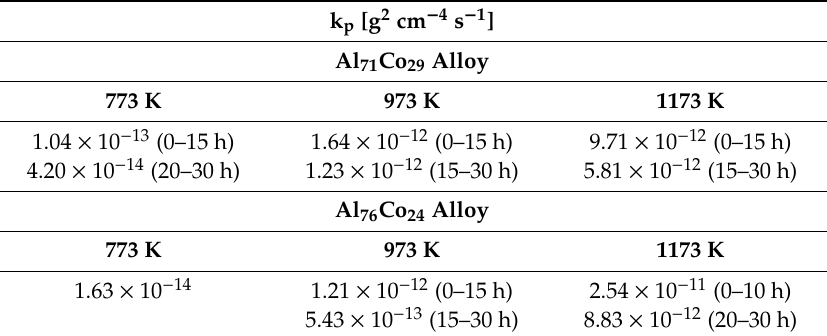
Table 2. Parabolic rate constants of the Al 71 Co 29 and Al 76 Co 24 alloys in air.